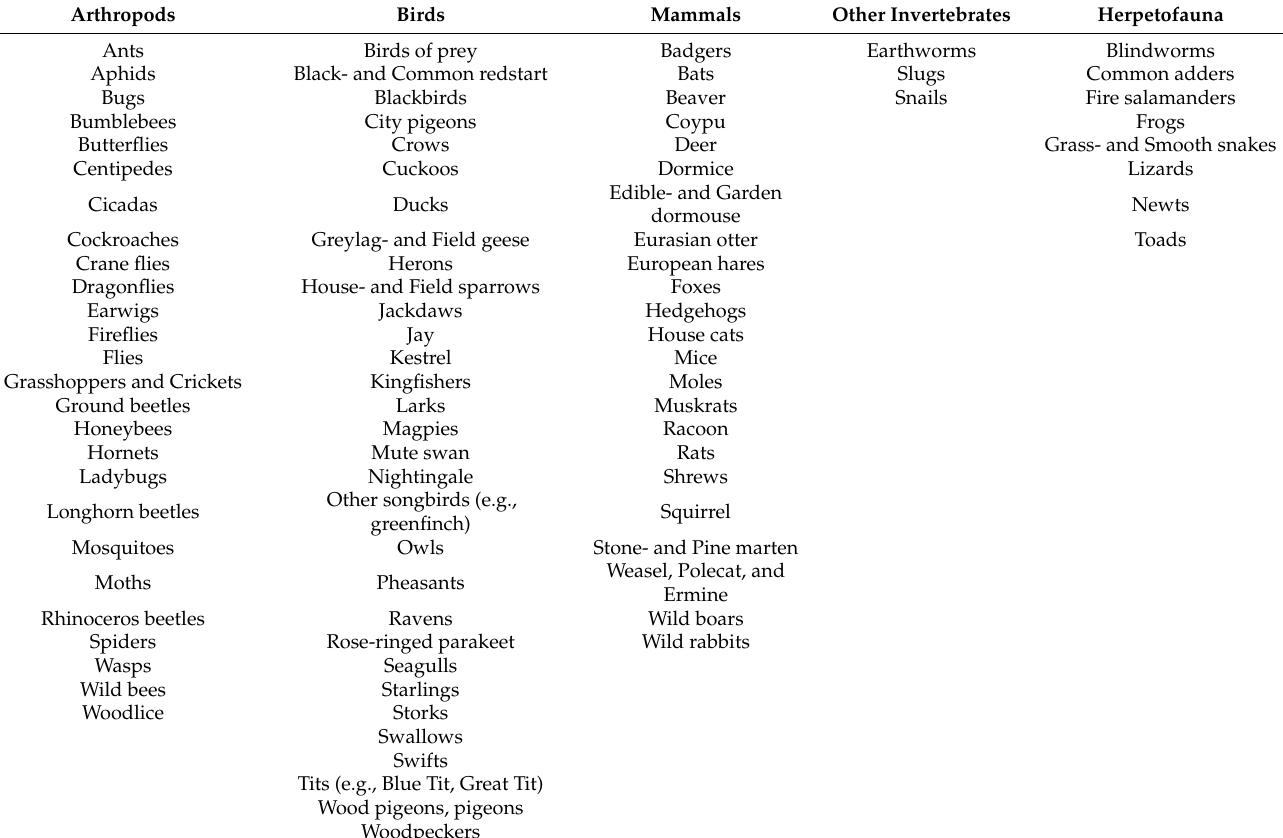
Table A1. List of